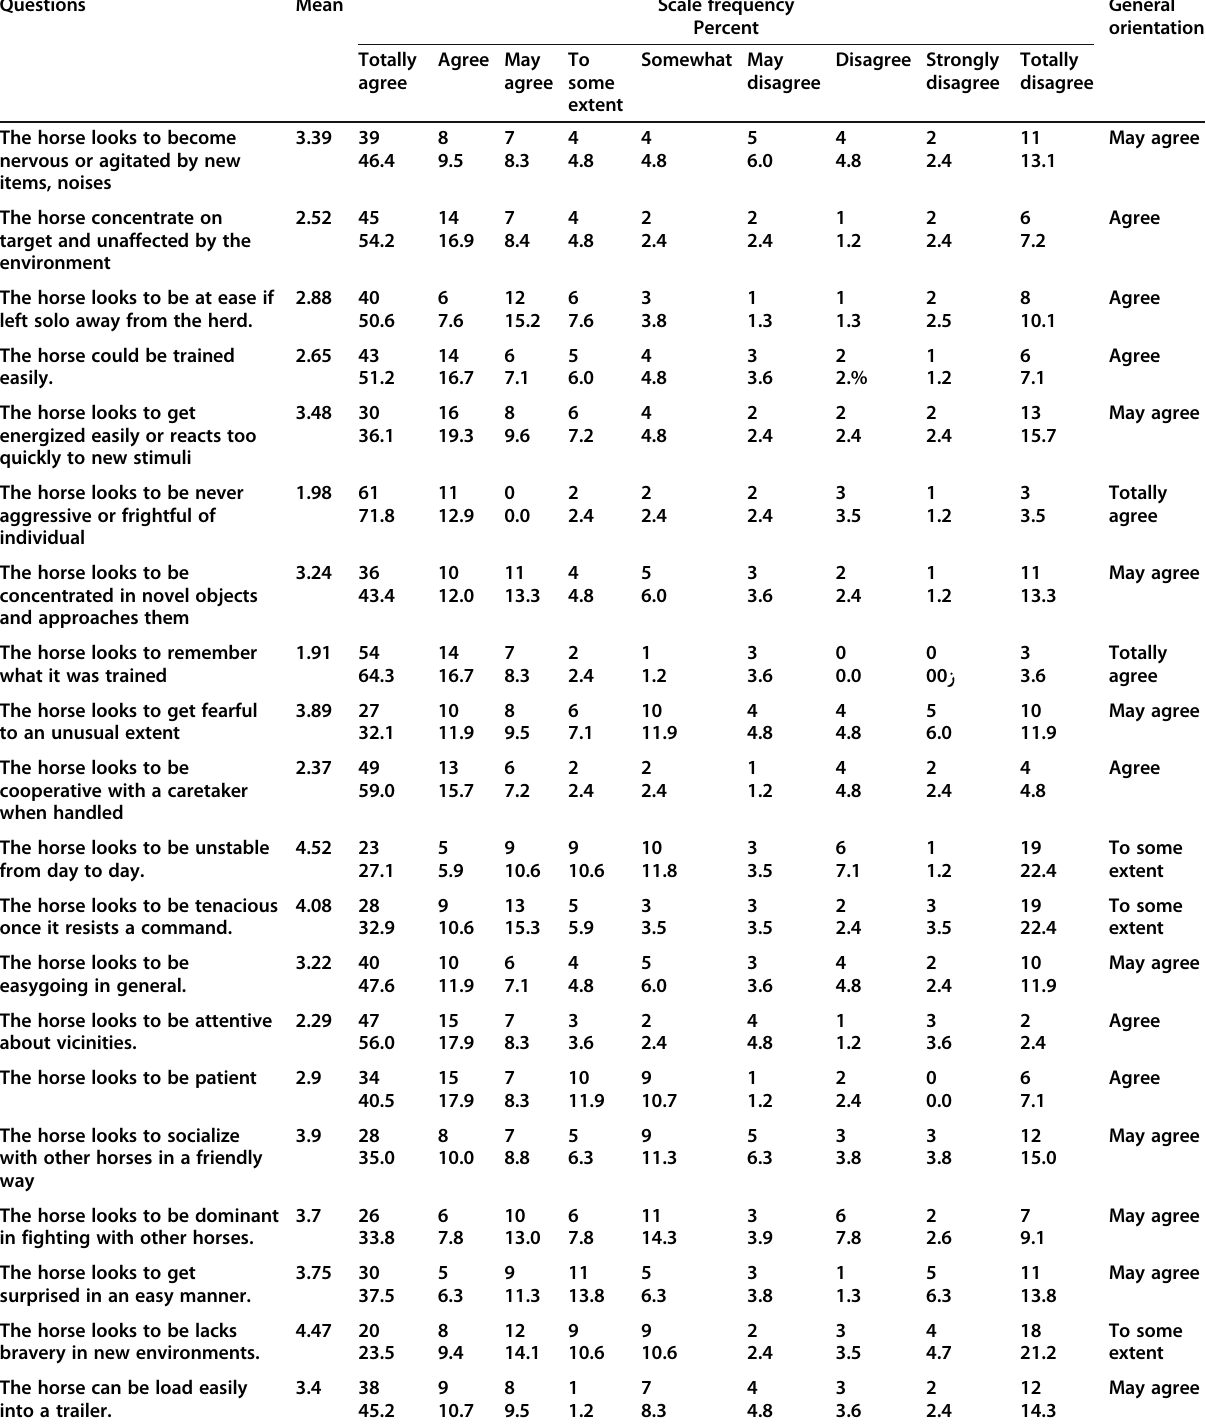
Table 1 Owners responses to part (C) questions (temperament scale questions)